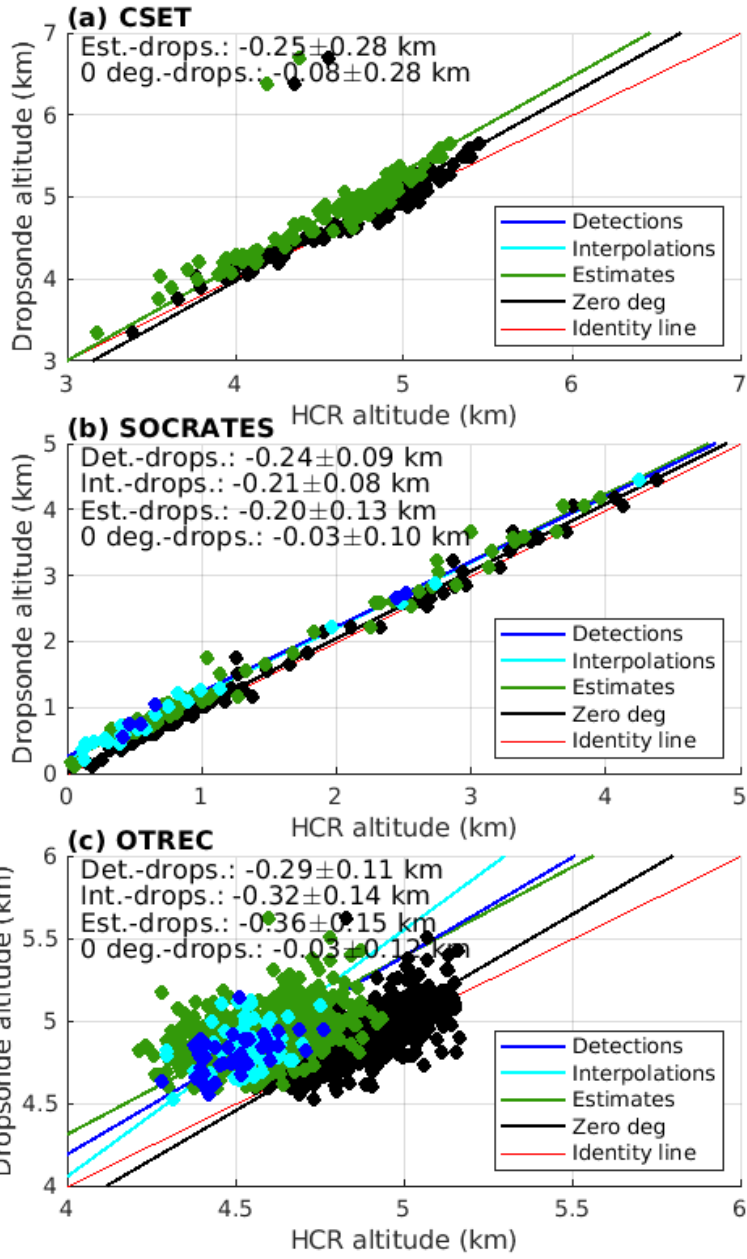
Figure 10. HCR identified melting layer altitude vs. dropsonde 0 °C isotherm for the ( a ) CSET, ( b ) SOCRATES, and ( c ) OTREC field campaigns. Shown are comparisons of detected (dark blue), interpolated (light blue), estimated (green) melting layer, and ERA5 0 °C isotherm (black) data. The identity line is shown in red. Offsets and standard deviations are listed in the upper left corners.